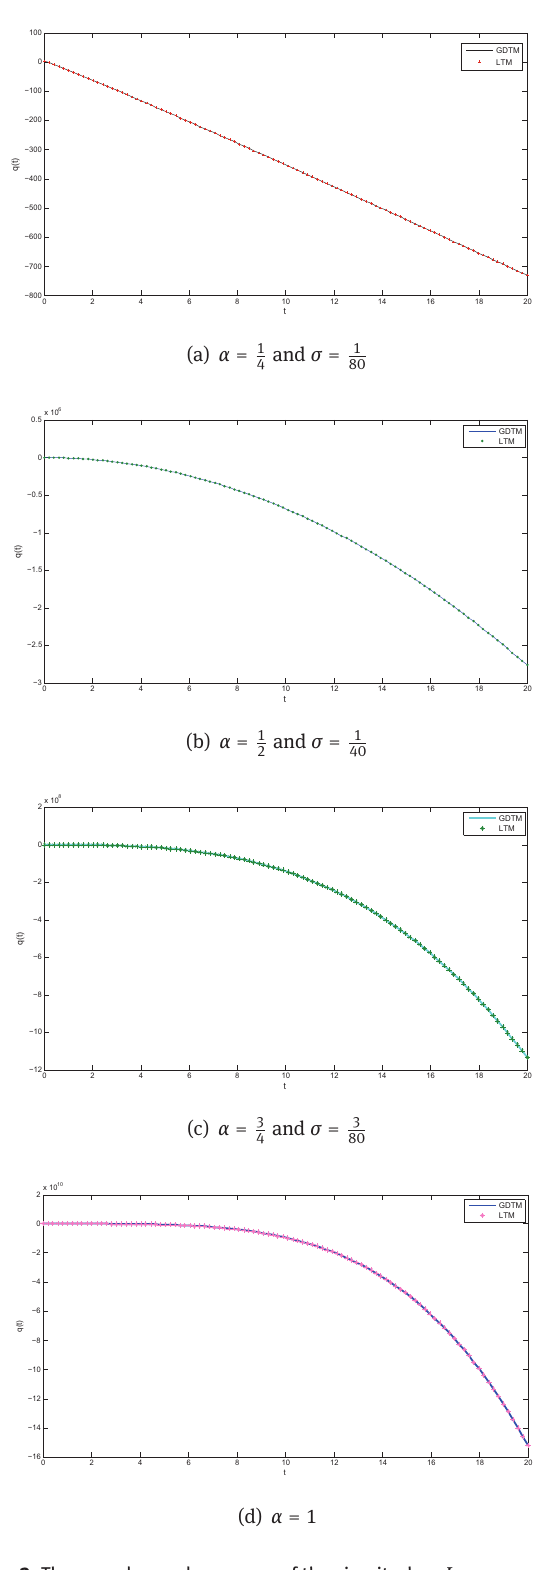
Fig. 3: The over-damped response of the circuit when L = mF ; E ( t ) = 100 v , q 0 = 4 C , q 1 = i (0) = 0 A 0.25 H ; R = 20 Ω ; C = 1 300 .